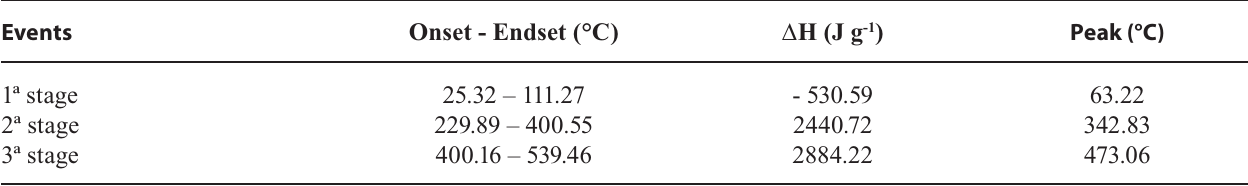
TABLE IV - Data of differential thermal analysis of the roots from T.